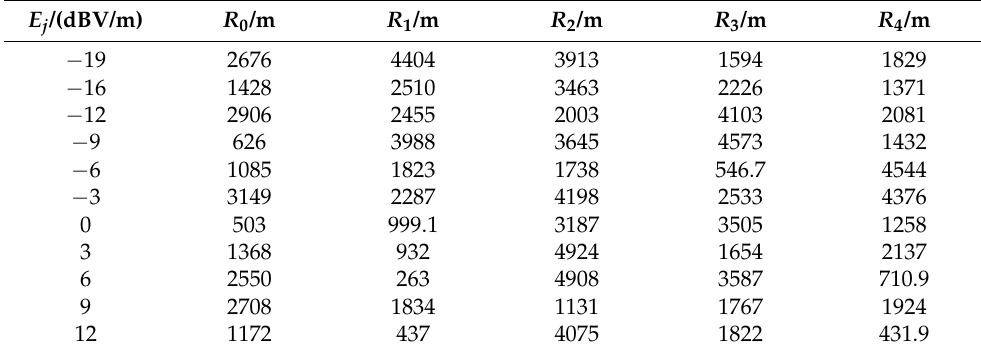
Figure 3. Results of false alarm sensitive threshold of test equipment. Table 2. Position of false alarm signal under single frequency electromagnetic